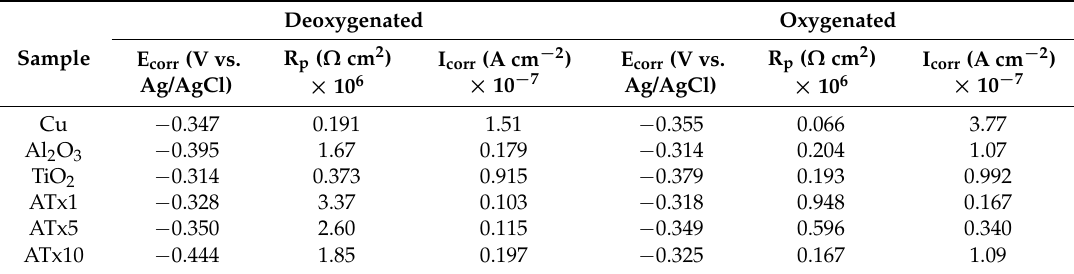
Figure 3. DC polarization curves: ( a ) forward scan [ − 1, 0.8] V and ( b ) reverse scan [0.8, − 1] V measured at a scan rate of 0.5 mV/s in oxygenated 0.1 M NaCl. Solid arrows specify scan direction and dashed arrows indicate features of interest. Refer to Table 1 for sample descriptions. Table 2. Corrosion potential (E corr ), polarization resistance (R p ), and corrosion current (I corr ) determined from polarization curves found in deoxygenated (Figure 2) and oxygenated (Figure 3) 0.1 M NaCl.